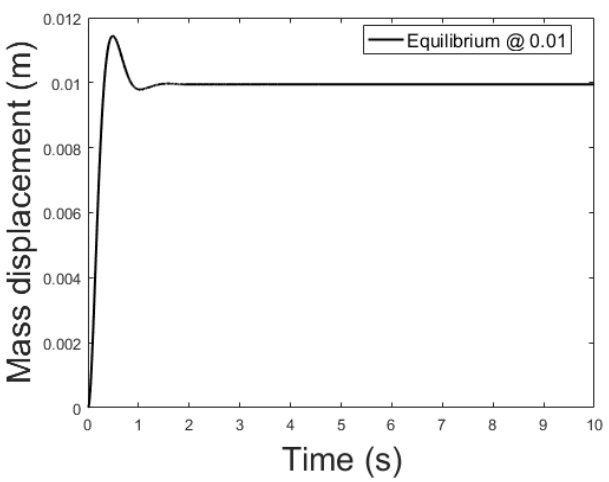
Figure 15. Observer controlled system output with equilibrium at x = 0.010.